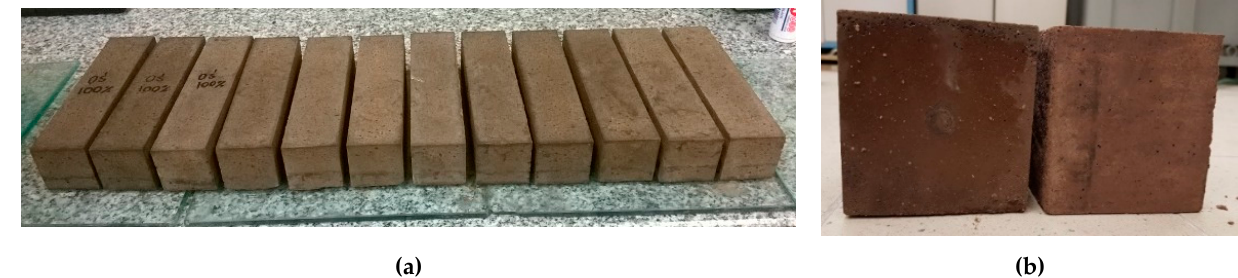
Figure 6. Specimen for determination of hardened properties; ( a ) prisms 40 mm × 40 mm × 160 mm; ( b ) samples 100 mm × 100 mm × 50 mm.